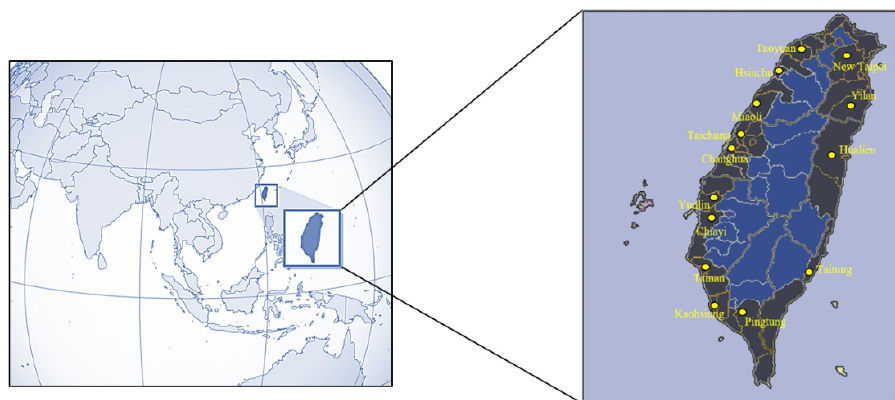
Figure 1. Geographic location of Taiwan and the study area (shadow zones).